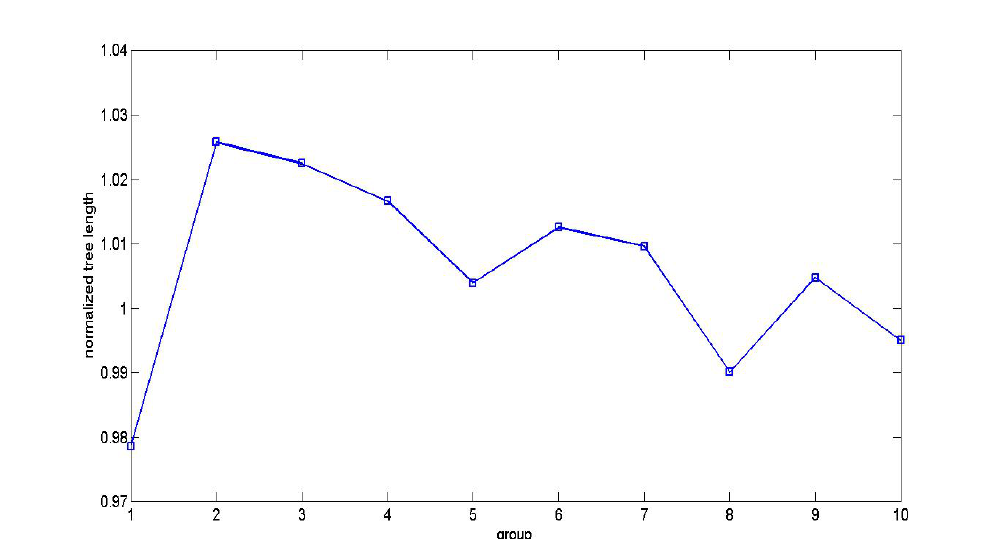
Figure 6. The mean value of the normalized tree length in each group according to the average return of the FX market index with the corresponding time window.